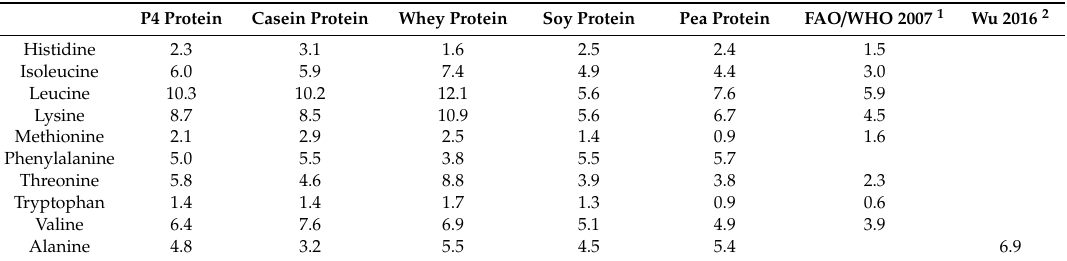
Table 1. Protein amino acid composition of the study products (gram / 100gram protein). P4